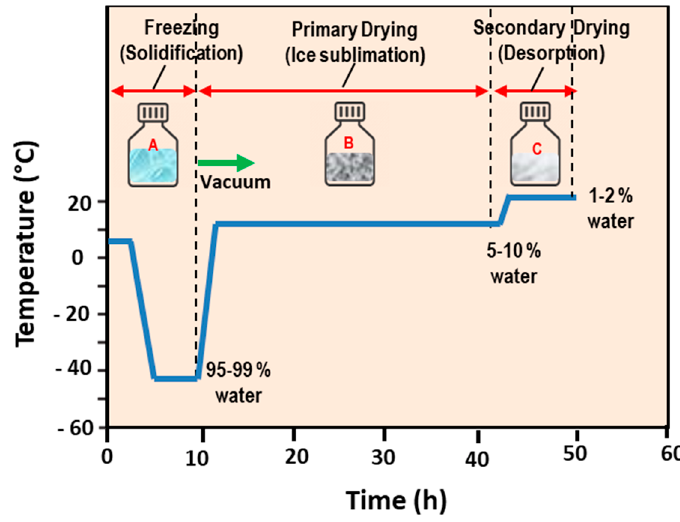
Figure 7. Schematic representation of the main stages of the freeze-drying (lyophilization) method. After the loading of the sample container (in flasks/vials), the system undergoes an initial freezing at atmospheric pressure, which is characterized by the formation of ice crystals ( A ), followed by a primary drying (ice crystal sublimation) ( B ) under vacuum. A secondary drying under vacuum favors the desorption of unfrozen water ( C ). Finally, the sample (product in vials) undergoes a backfill and stoppering process under partial vacuum, followed by the removal of the dried product from the freeze